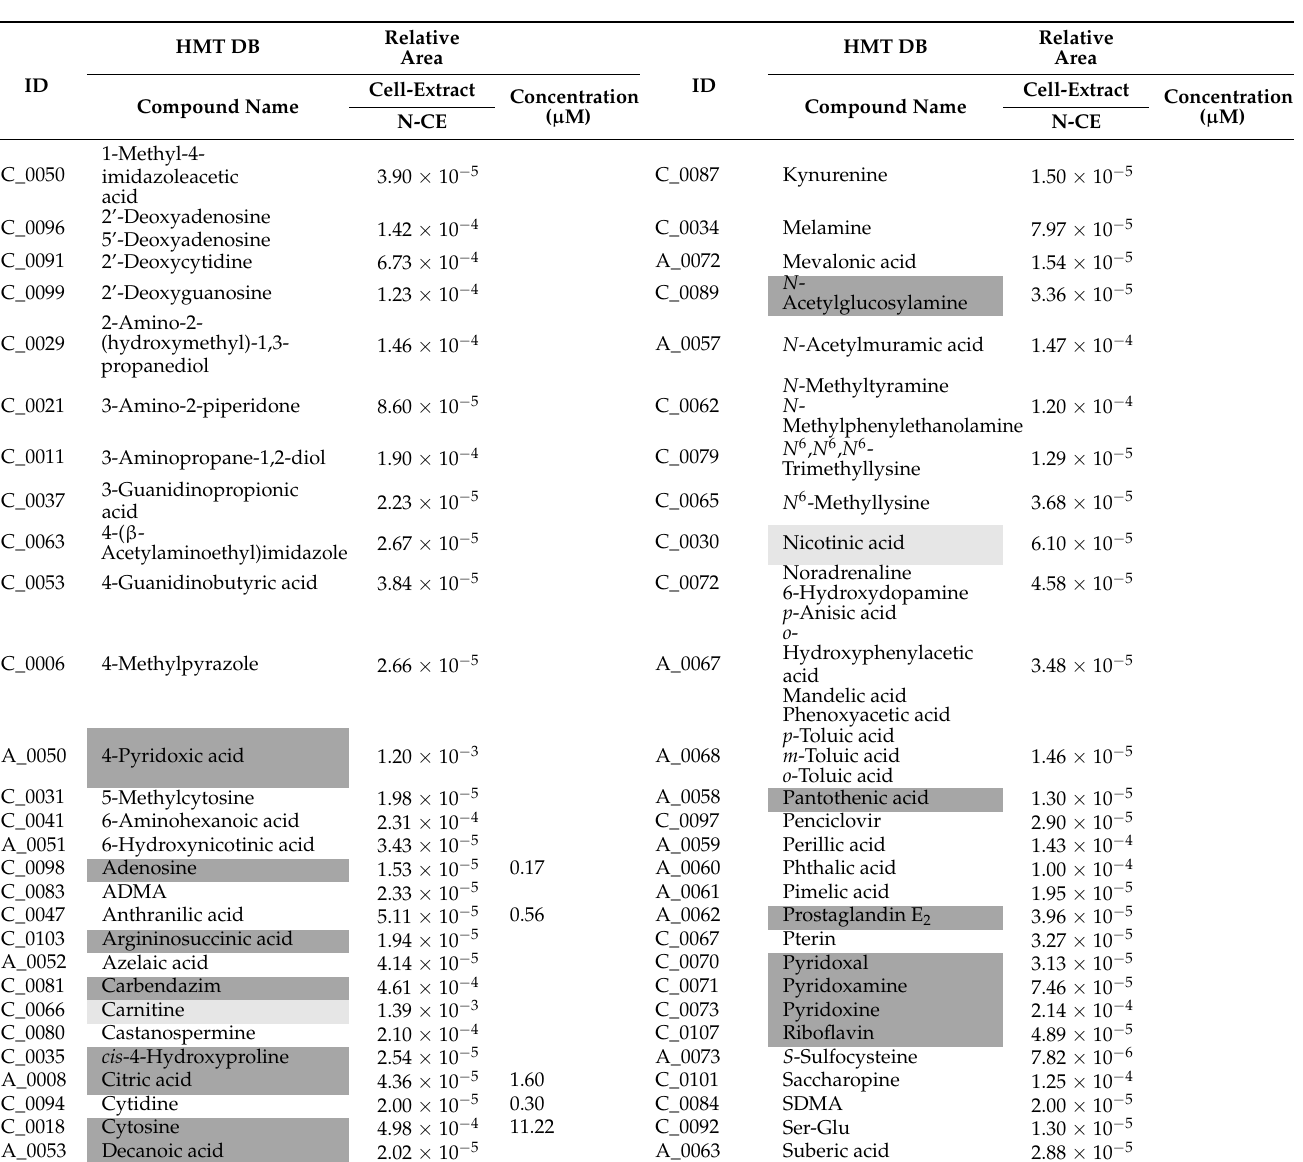
Table 1. Component metabolites with narrowed down candidates in